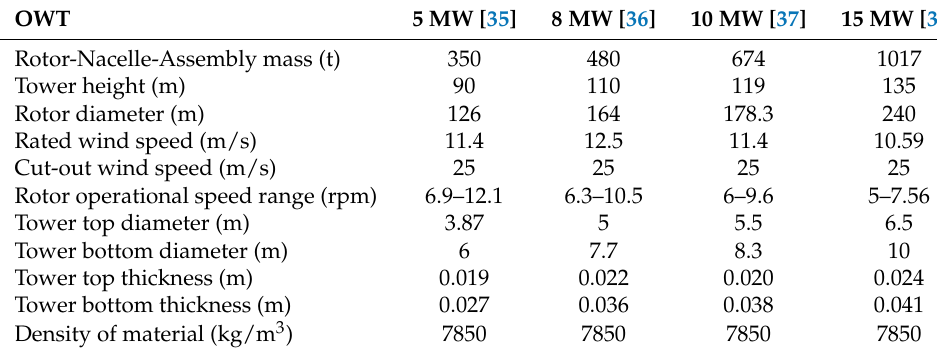
Table 1. Definition of the set of OWTs used in the present study.